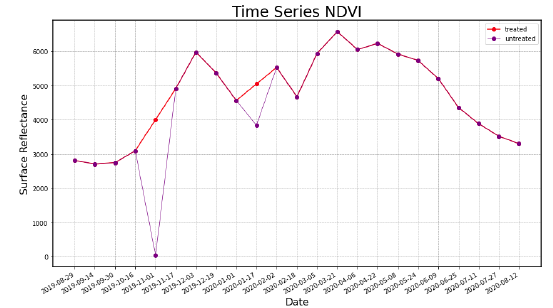
Figure 3. Example of an interpolated NDVI time